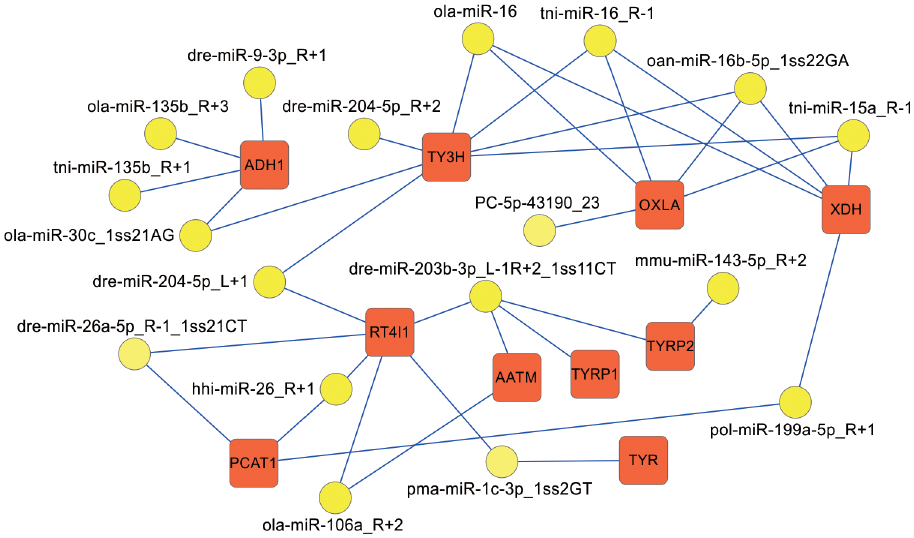
Fig 10. A proposed network of putative interactions between miRNAs and mRNAsin tyrosine metabolism. The regulationnetwork of miRNAs and mRNAs involvedin tyrosine metabolismis illustratedby Cytoscape. Yellowellipses represent miRNAs, and red rectanglesindicate their target genesassociatedwith tyrosine metabolism.Abbreviations of the genes are detailedin the text.